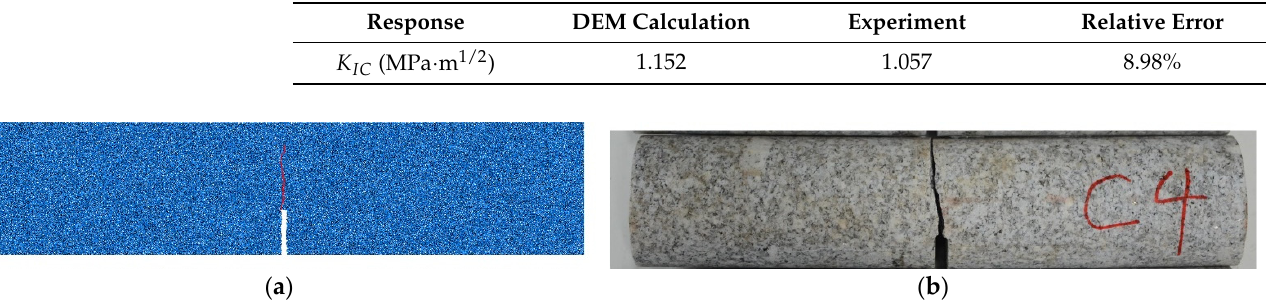
Table 7. Comparison of discrete element simulation results with experimental results.